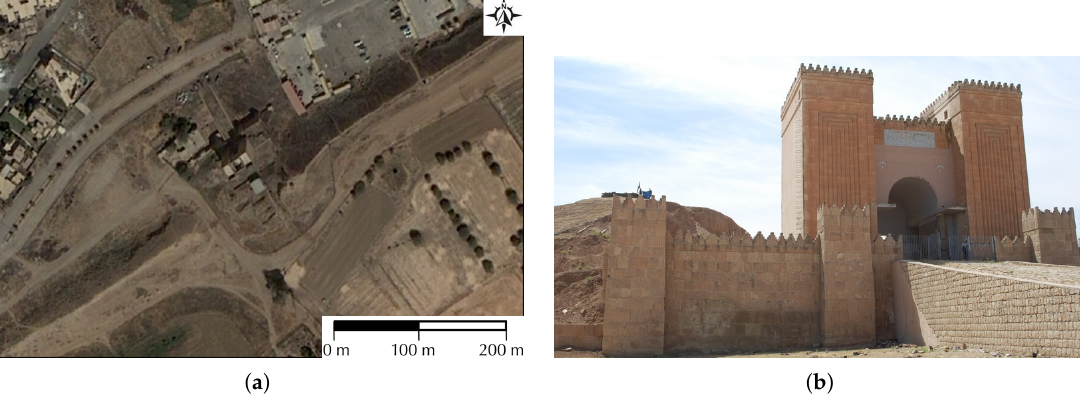
Figure 22. Overview of the Nergal Gate before the destruction: ( a ) GeoEye-1, 21 August 2014 c (cid:13) DigitalGlobe; and ( b ) ground view as seen in 2006 [76]. In May 2016, ISIL released pictures showing a bulldozer close to Nergal Gate’s ramp, apparently disgorging a possible section of sculpture into a waiting dump truck (Figure